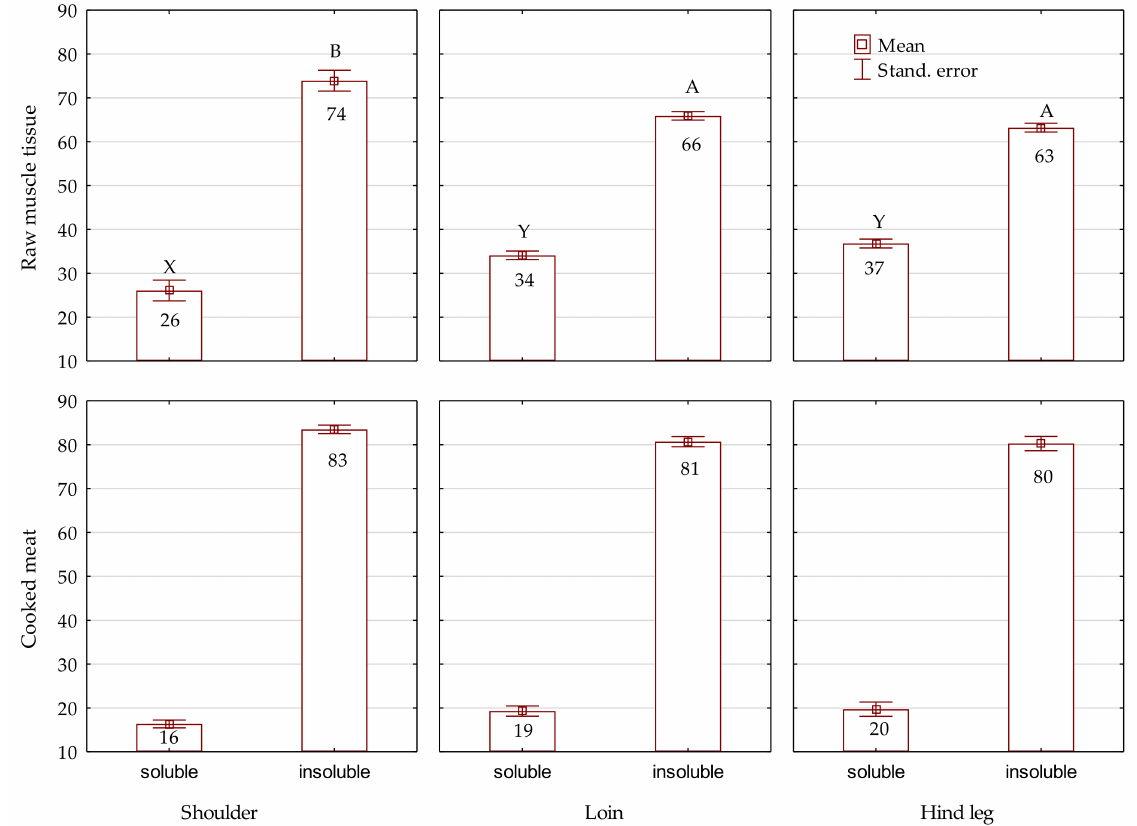
Figure 1. Collagen fractions (% in total collagen) in raw muscle tissue and cooked meat of beaver. Significant differences (X, Y) within soluble fraction ( p < 0.01); significant differences (A, B) within insoluble fraction ( p < 0.01).